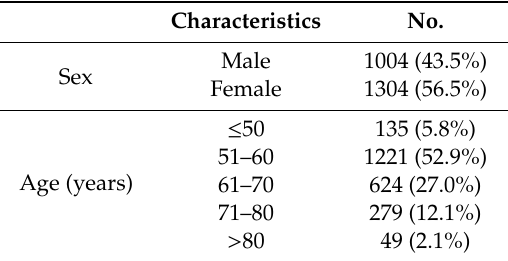
Table 1. Demographic characteristics of sample population ( n = 2308).